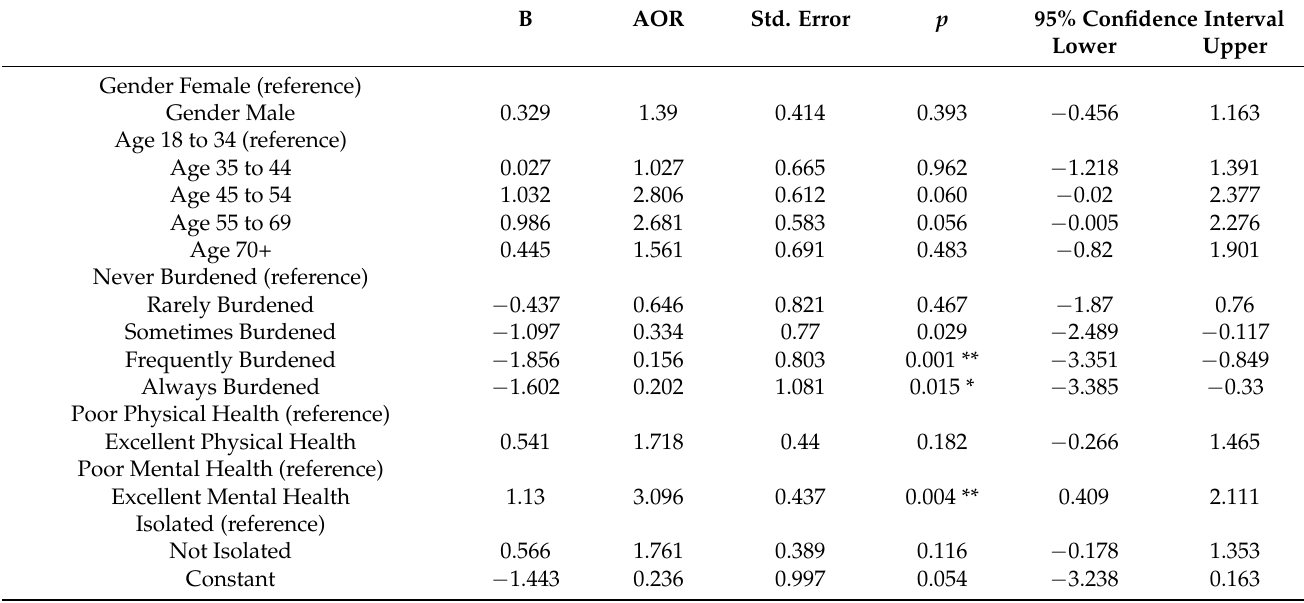
Table 5. Predictors of never lonely ( n = 290).